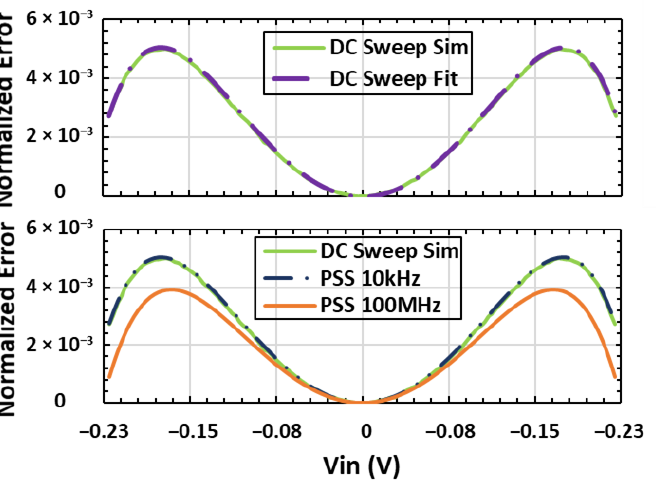
Figure 7. Relative error of the input–output characteristic obtained through DC sweep simulation and polynomial coefficient from DC sweep fitting and from harmonics of PSS simulation.